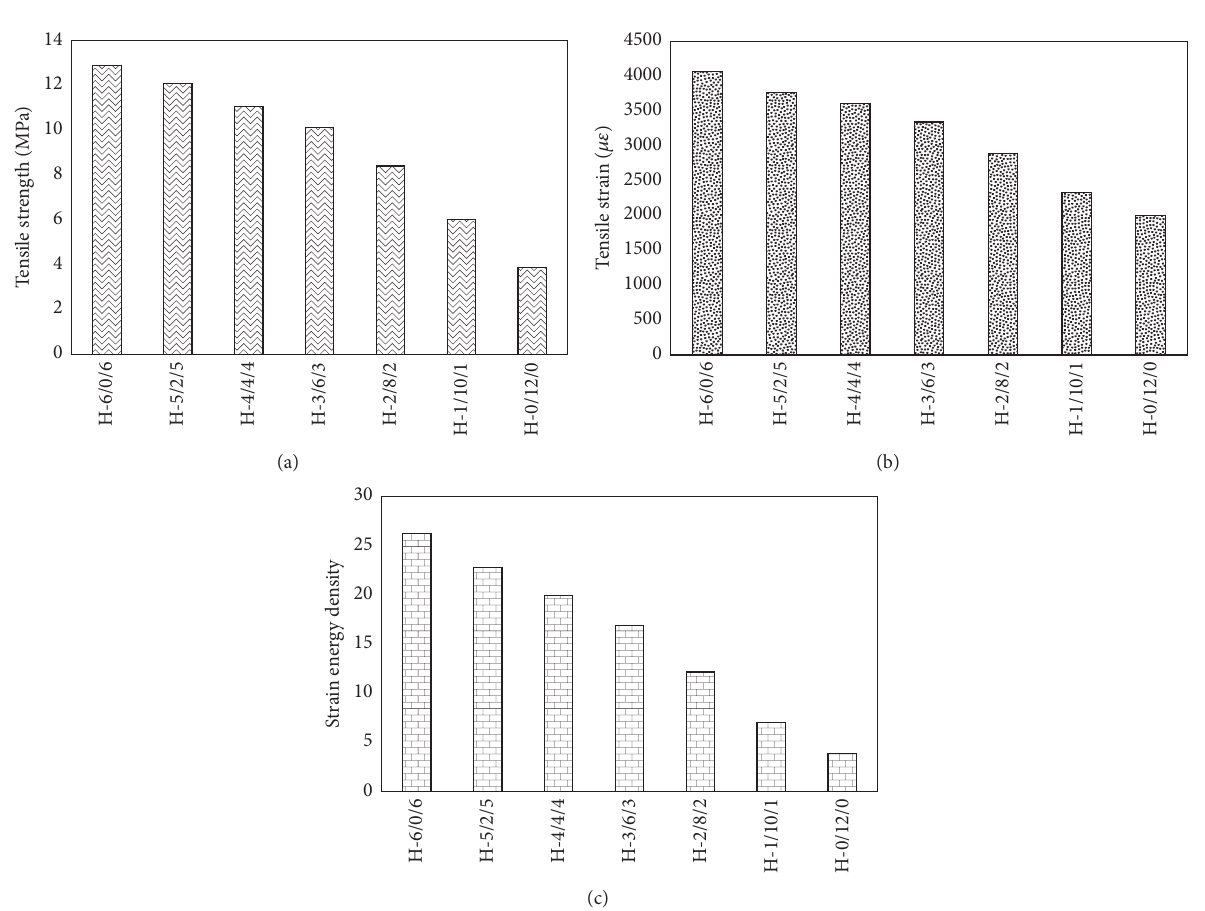
Figure 12: Testing results under different nonuniform horizontal distribution of air voids: (a) tensile failure strength; (b) tensile failure strain; (c) strain energy density.